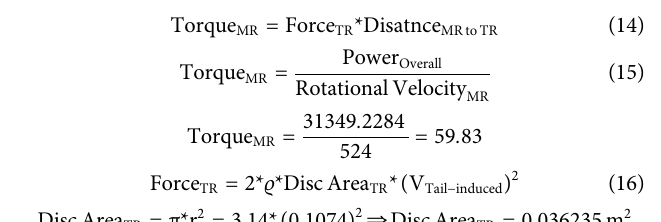
Vijayanandh et al., 2022a; Raja et al., 2022b; Raja et al., 2022c; Raja